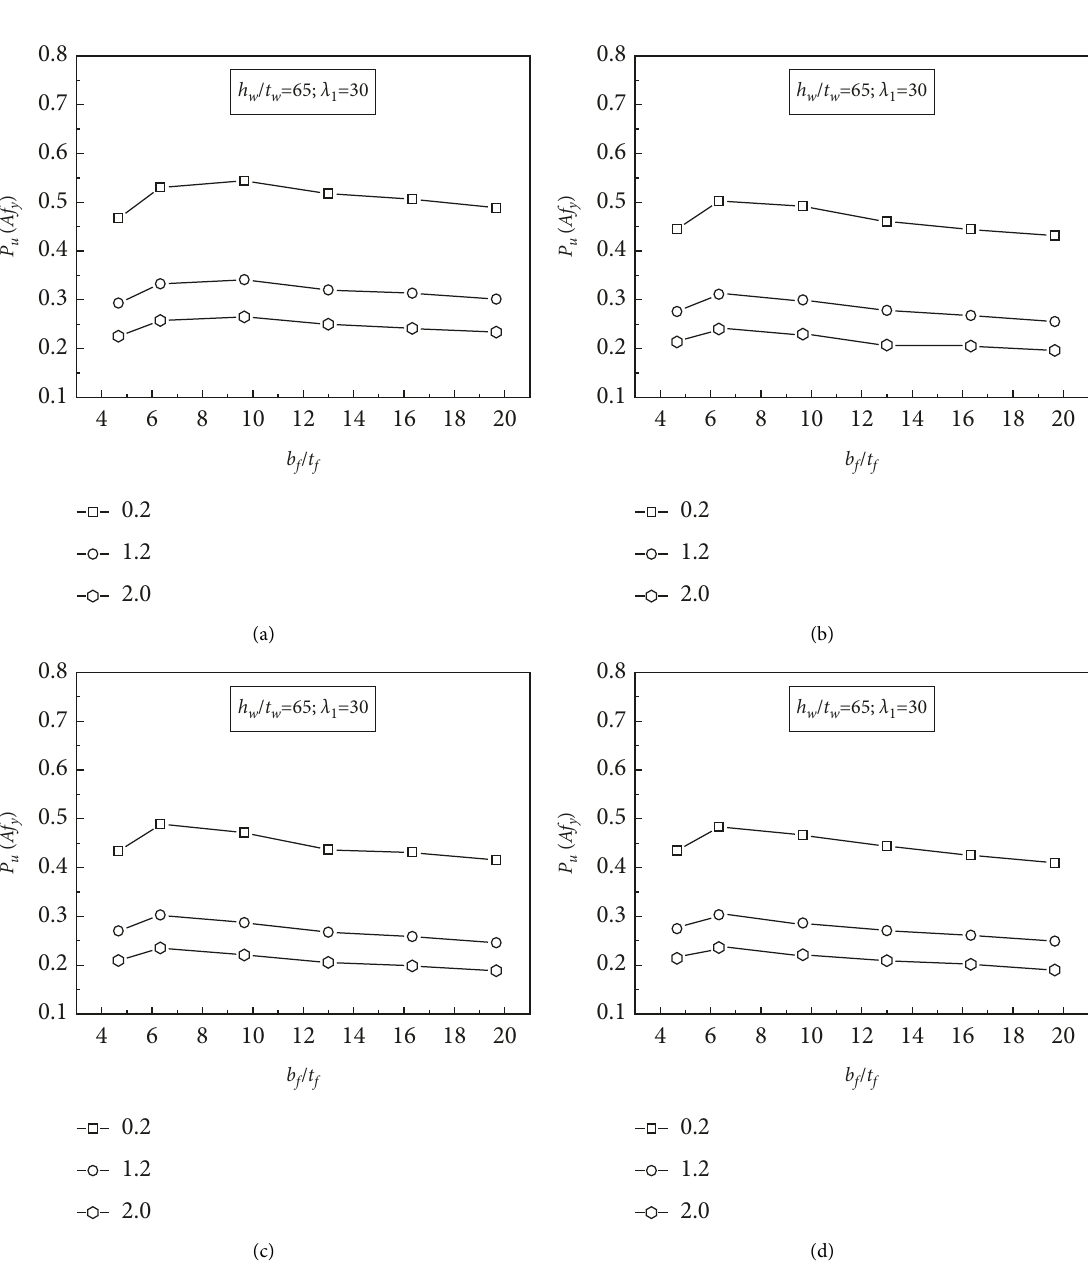
Figure 8: P u / Af y versus b f / t f under different &epsi; curves: under different &epsi; curves: (a) Q460; (b) Q690; (c) Q800; and (d)